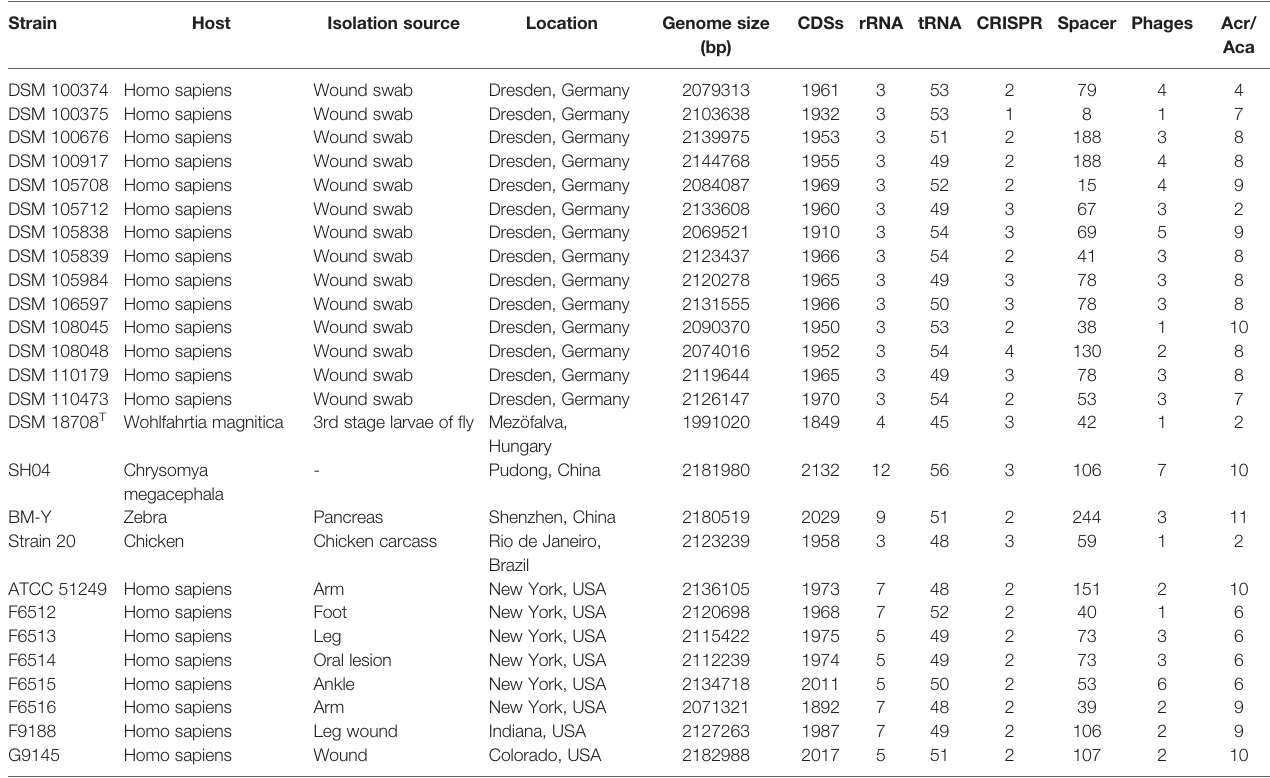
TABLE 1 | Overview of the general genome features of the W. chitiniclastica genomes analyzed in this study.